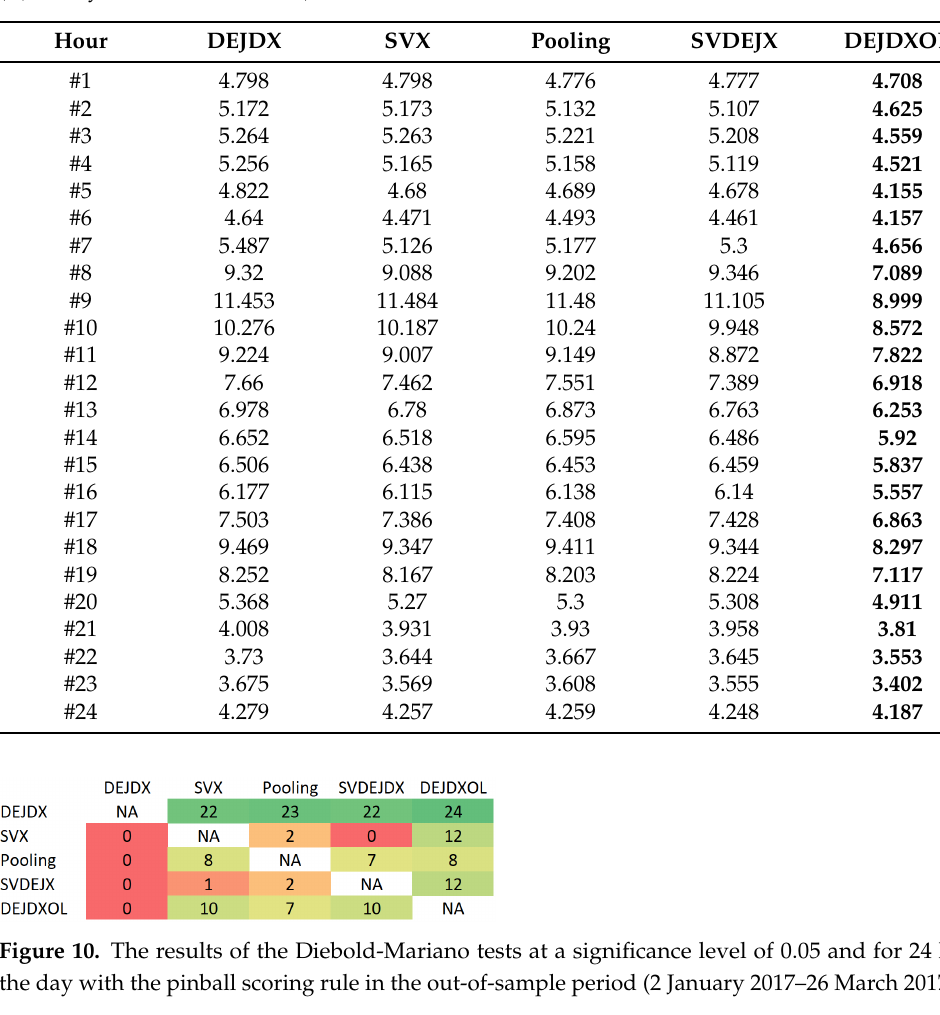
Table 1. The mean absolute percentage errors (MAPEs) (%) calculated within the DEJDX, SVX, pooling, SVDEJX and DEJDXOL models for each hour of the day in the out-of-sample period (2 January 2017–26 March 2017). The best results for each hour are in bold.